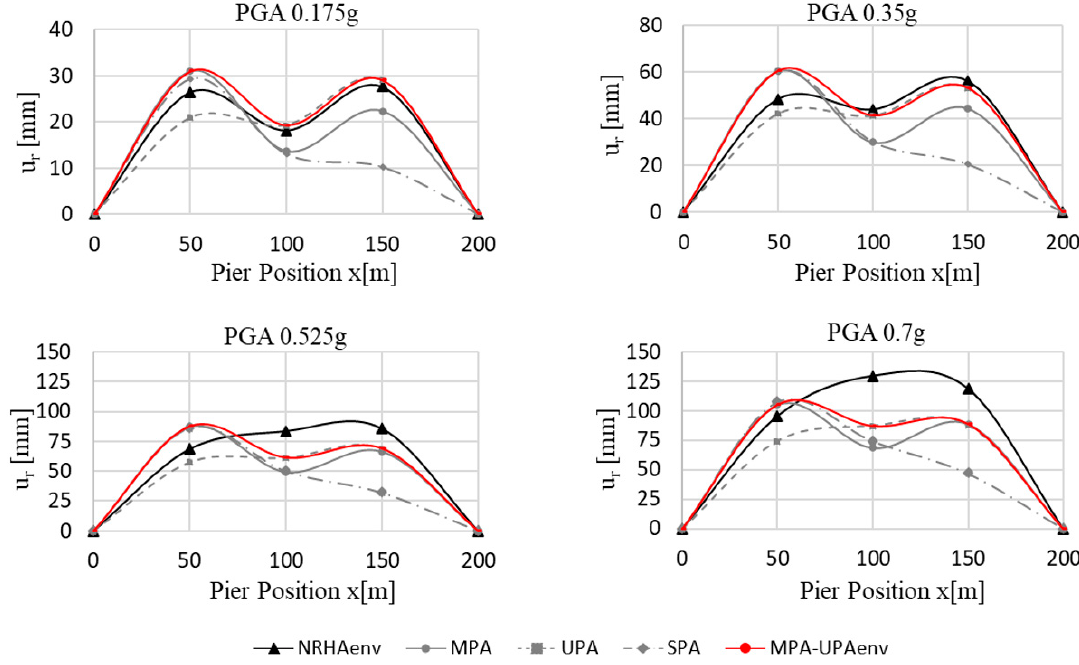
Figure 20. Irregular bridge—deck displacements derived by performing nonlinear dynamic analysis and pushover analysis according to the approaches considered (PGA from 0.175 to 0.7 g).